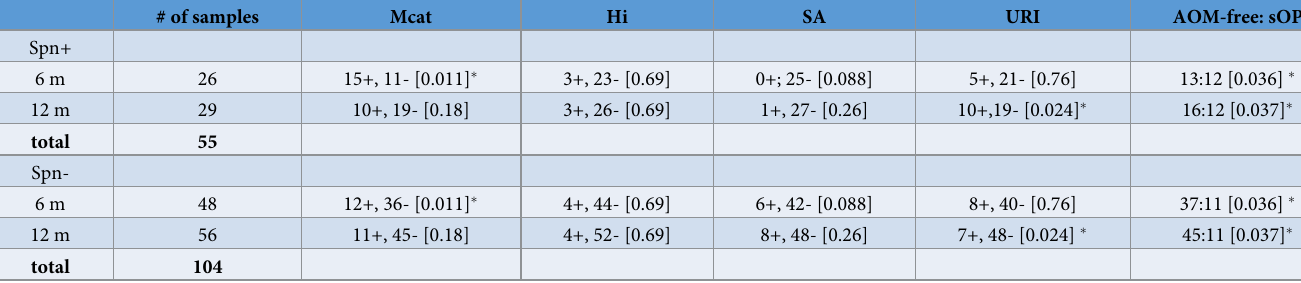
(Table 1). Gender, race, breast-feeding history, exposure to smoke, history of atopy, antibiotic treatment (30 days prior to sample collection), daycare attendance, and presence of siblings were variables that had frequently been examined for their association with Spn colonization and some were reported as risk factors [34–39]. We evaluated these factors in our cohort. As previously reported [34], daycare attendance correlated significantly with Spn colonization in the child’s NP, but none of the other demographic factors did in this study cohort (Table 1). We investigated the association between Spn colonization and common respiratory patho- gens, clinically-diagnosed viral upper respiratory infection (URI), and proness to acute otitis media (AOM) (Table 2). Spn colonization in NP has been reported to positively correlate with colonization of other otopathogens and with URI [36, 40]. In our study, Moraxella catarrhalis detected by culture was significantly associated with Spn carriage at 6 months, although not at 12 months (Table 2). Haemophilus influenzae (Hi) did not show significant association with Spn colonization although our group has previously reported an association [40]. This lack of significance in association could be due to the fact that few samples were positive for Hi in this cohort. Staphylococcus aureus did not show correlation with Spn colonization in our cohort (Table 2), although a negative association had been reported in other studies [41, 42]. URI was significantly associated with Spn carriage in 12-month samples but not so in 6-month samples (Table 2). AOM is a common disease in children and is frequently caused by Spn infection [43]. We have previously reported that while some children never develop AOM (AOM-free), some have frequent occurrences [44]. Those who develop at least 3 episodes of AOM (con- firmed by tympanocentesis) within 6 months or 4 episodes in 12 months were categorized as sOP (stringently-defined Otitise-Prone). Elevation of Spn colonization was reported in sOP children compared with AOM-free children [36]. Similarly, in our cohort, sOP children